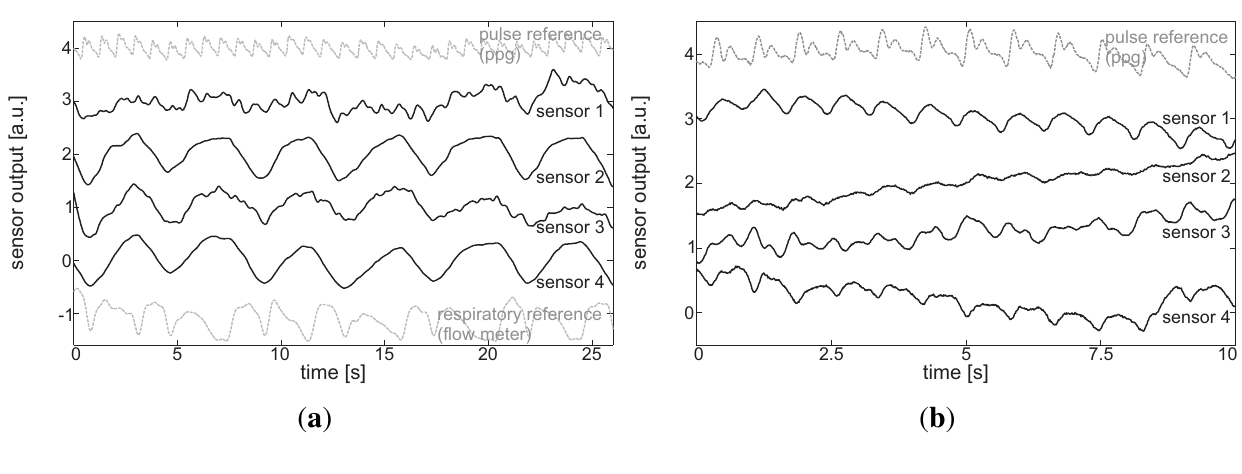
during ( a ) normal breathing and ( b ) apnea in a standing posture. For illustrative purposes, the signals are scaled to the same magnitude and shifted.